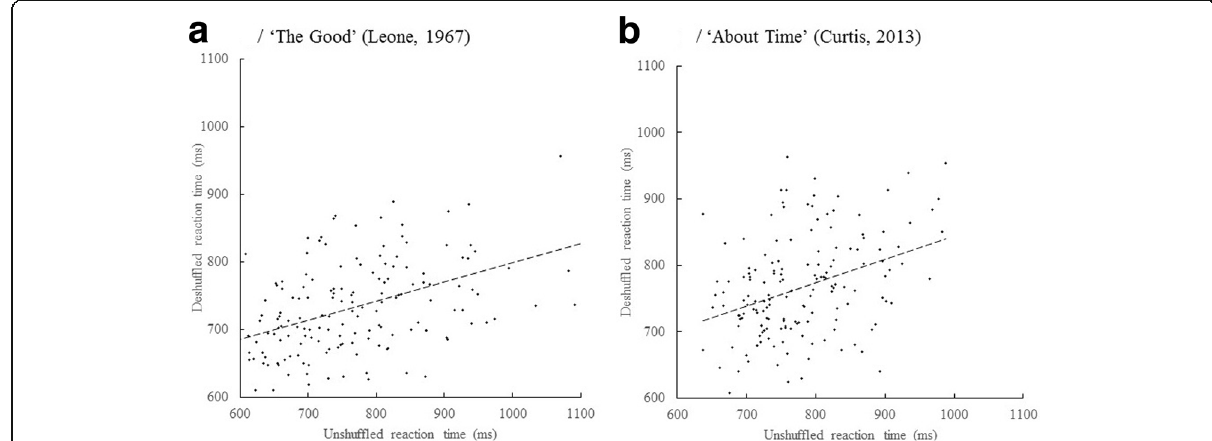
Fig. 4 Deshuffled mean secondary reaction time (RT) (ms) plotted against the unshuffled mean secondary RT (ms). a / The Good. b / About Time. Error bars are 95%